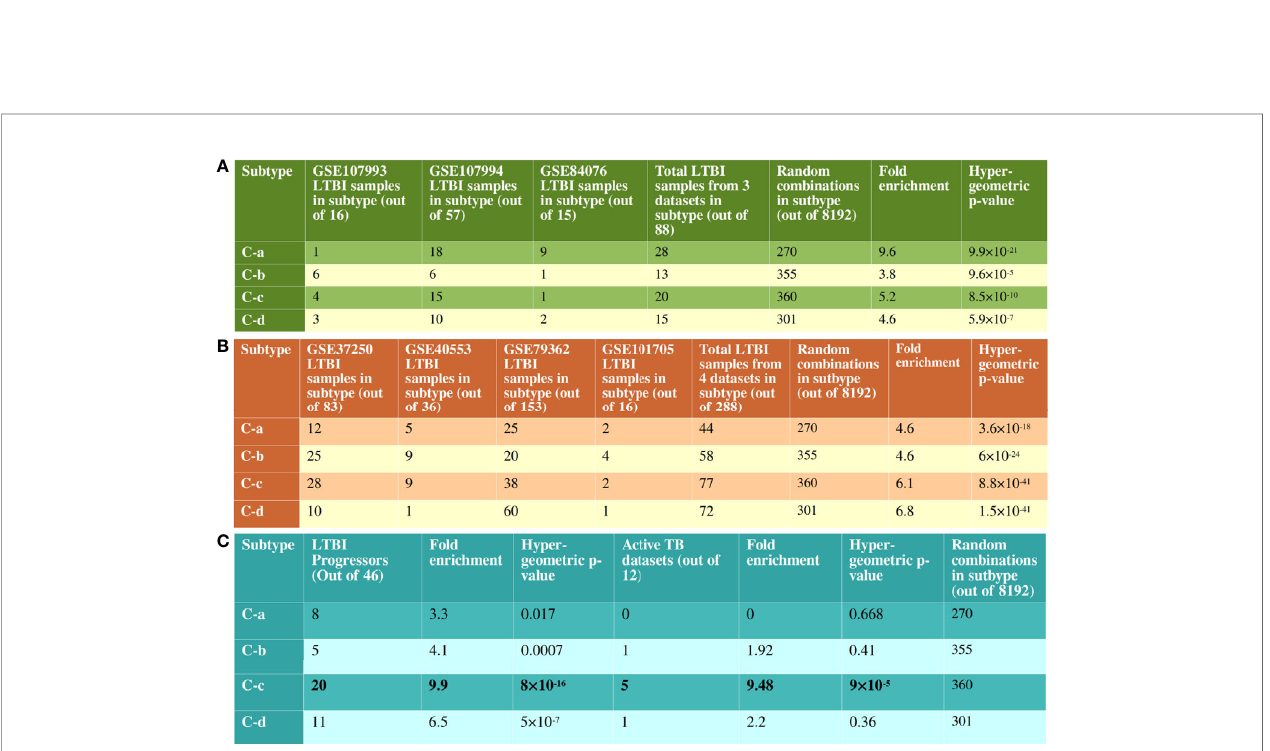
FIGURE 4 | Pathway perturbation pattern in sample clusters. The pattern of the perturbations in each sample arranged according to their clusters (as mentioned in Figure 3C ) is depicted in a binary scoring manner. Blue signi fi es that the pathway is perturbed in the patient and light yellow signi fi es no perturbation. Red lines demarcate the clusters.